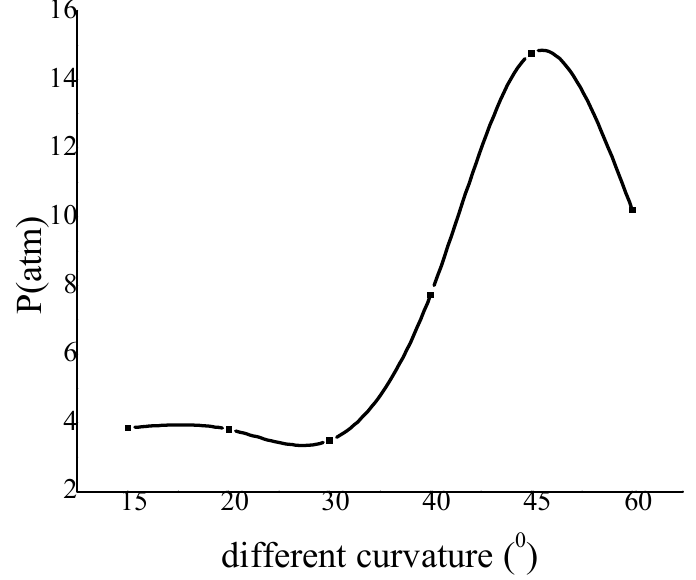
Figure 9. The variation of wall maximum pressure with